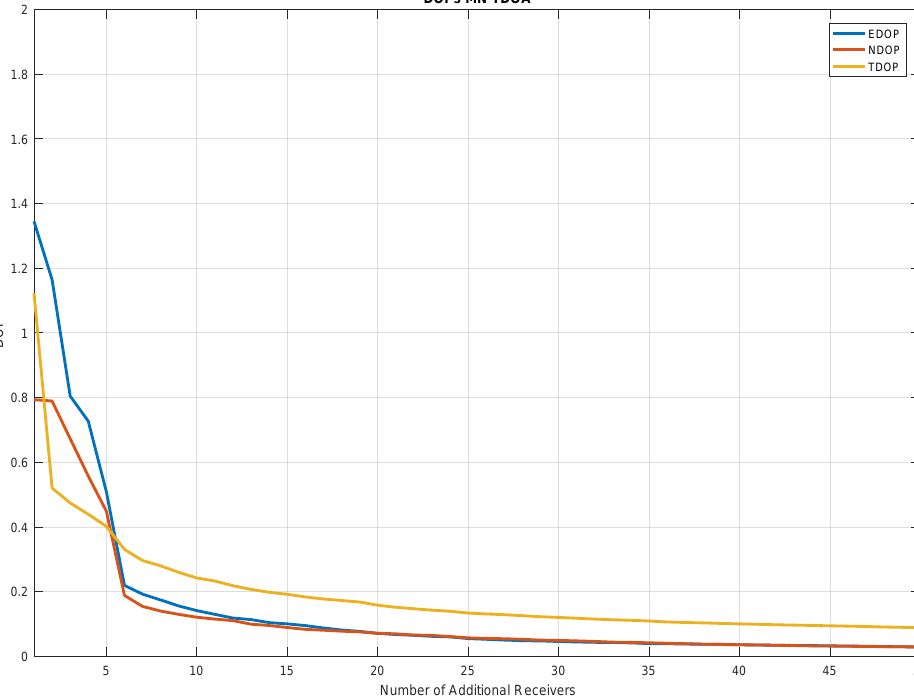
Figure 9. Dilution Of Precisions (DOPs) as a function of the number of additional receivers for the MN TDOA algorithm. East, north and time (INB) components of the DOP are represented, respectively, in blue, red and